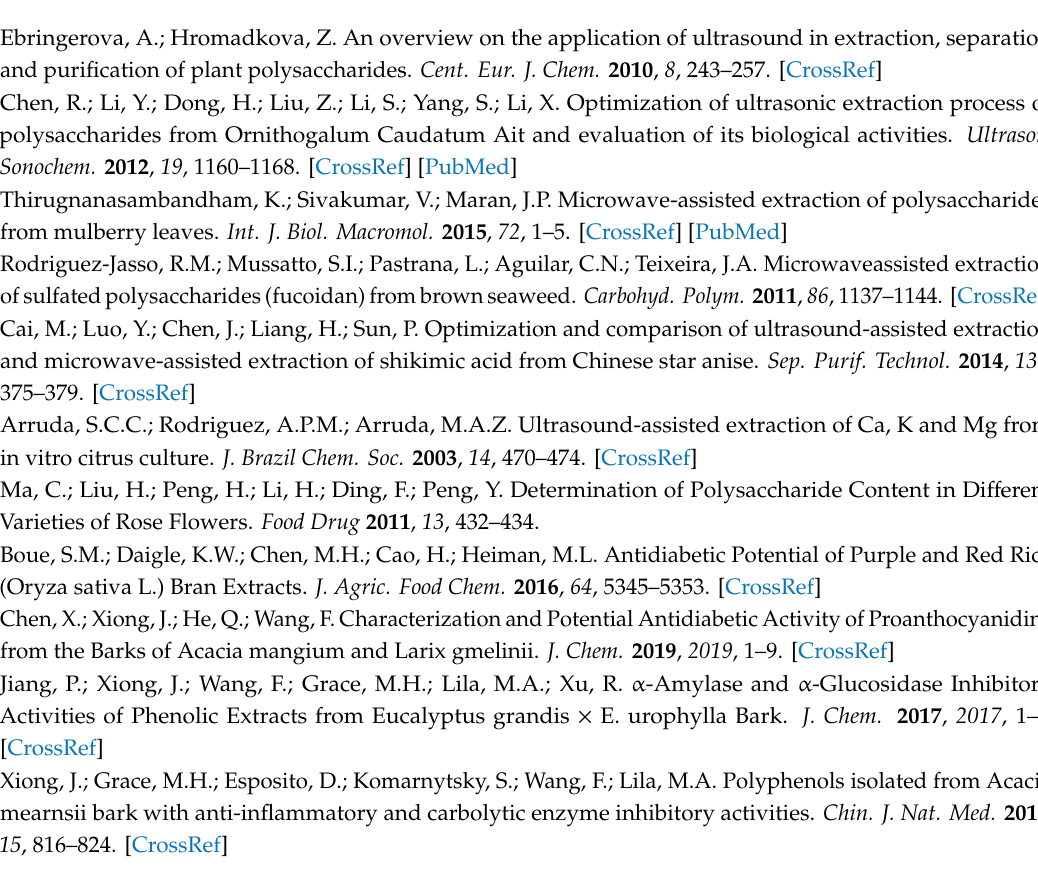
Sample Availability: Samples of the compound 80% alcohol-precipitated polysaccharide (Pe4) is available from the